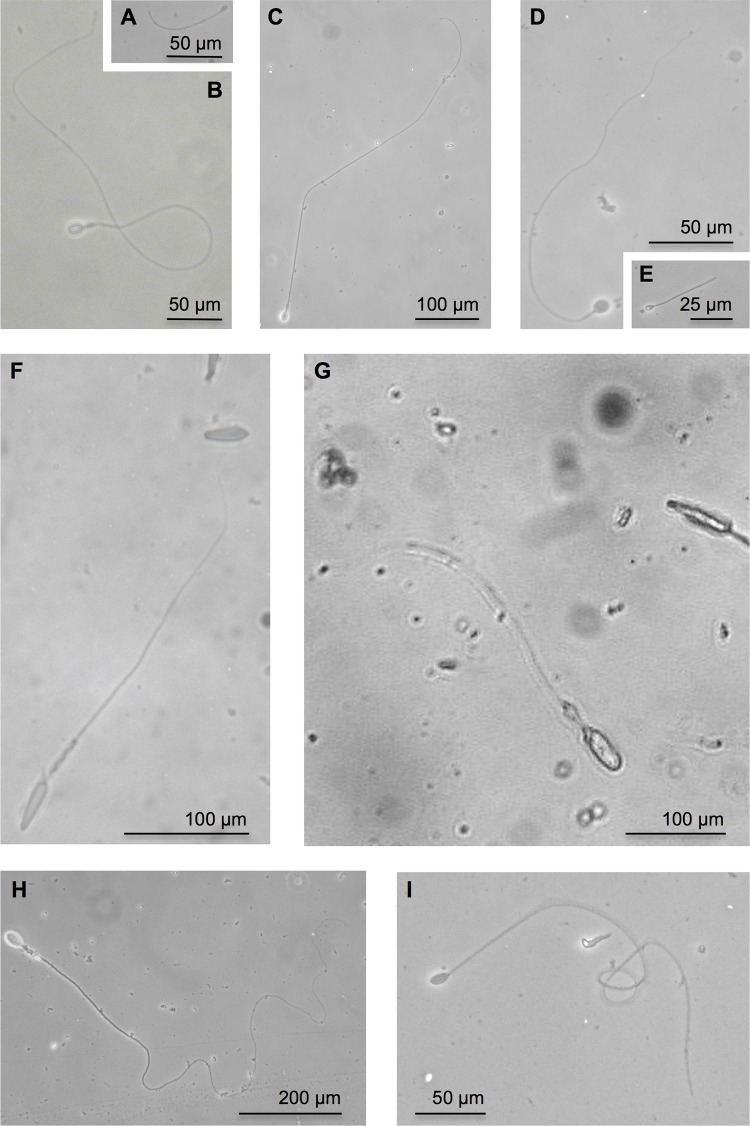
Micrographs of discharged nematocyst.The major discharged nematocysts in this study are shown. A and B were from A. aurita. C, D, and E were from C. pacifica. F and G were from C. yamaguchii. H and I were from C. brevipedalia. A) atrichous isorhiza, B) heterotrichous microbasic eurytele, C) heterotrichous microbasic eurytele D) atrichous isorhiza, E) isorhiza o-haploneme, F) microbasic mastigophore, G) large oval p-rhopaloid, H) heterotrichous microbasic eurytele and I) atrichous isorhiza. Scales are shown by the scale bar. Each nematocyst was identified by referring to previously described nematocyst nomenclature [1, 2, 23–26].